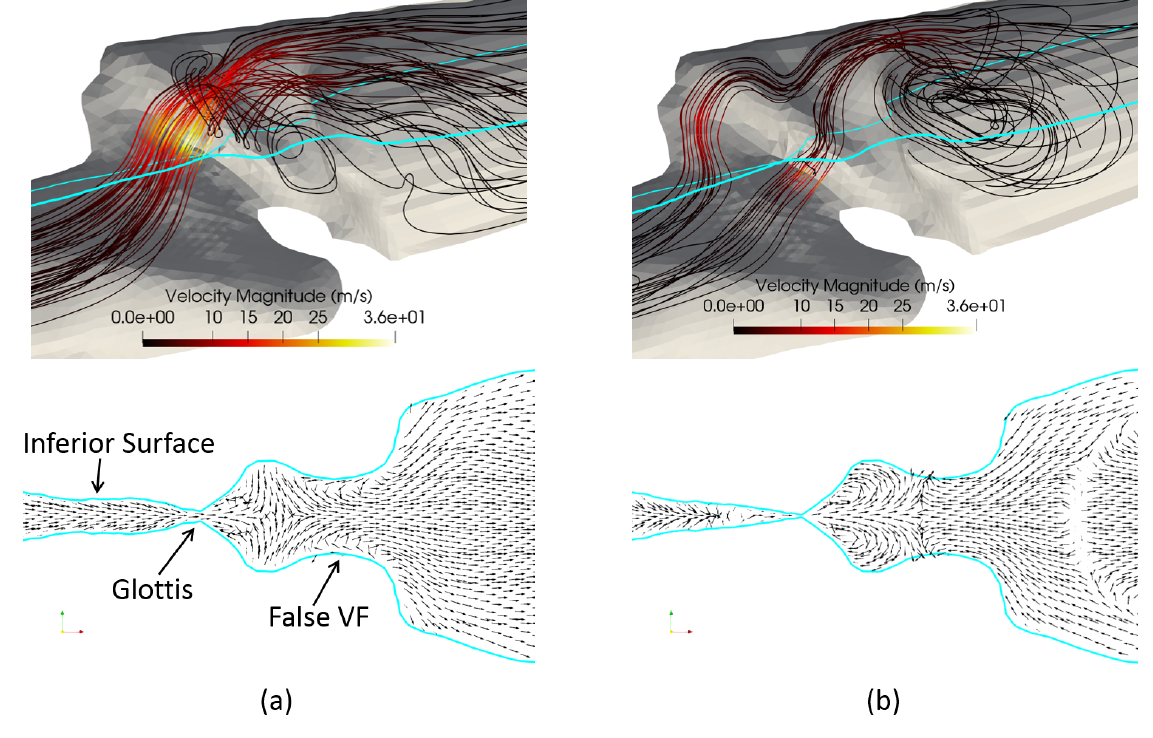
Figure 11. 3D flow pattern in Sample 3 at ( a ) vocal fold opening ( t = 0.6 cs) and ( b ) vocal fold closing ( t = 0.66 cs). Bottom row: corresponding velocity field in the cut plane (blue lines) shown in the top